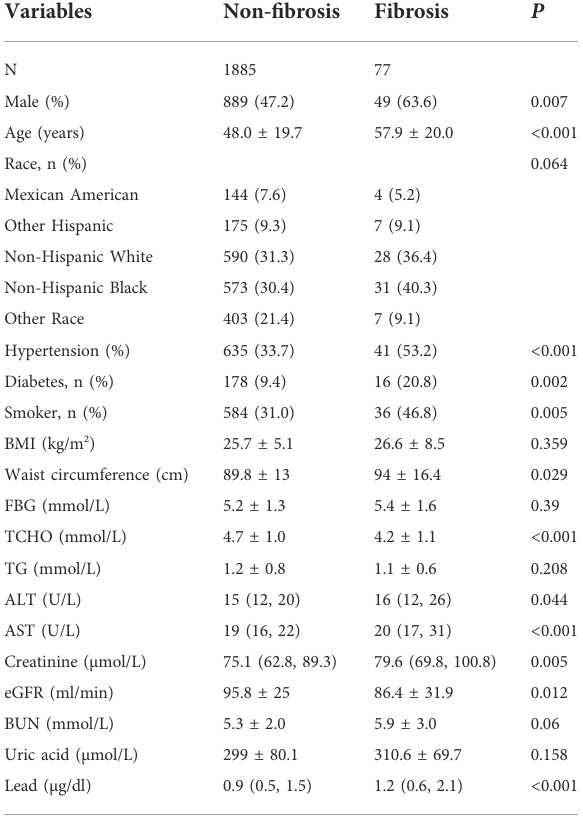
TABLE 3 Comparison between the fi brosis and non- fi brosis